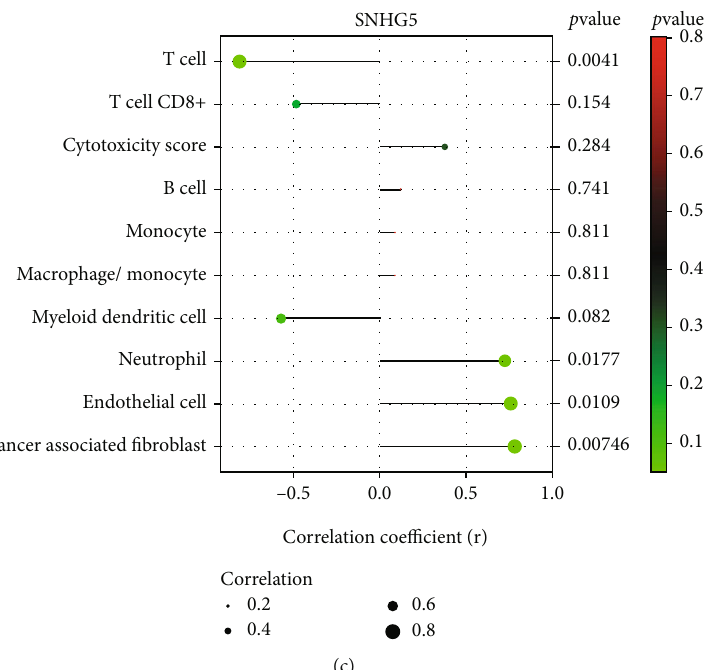
Figure 9: Correlation analysis results between genes and immune in fi ltrating cells. (a) Correlation analysis of immune in fi ltrating cells. (b) Correlation coe ffi cient plot of ATF2 and immune in fi ltrating cells. (c) Correlation coe ffi cient plot of SNHG5 and immune in fi ltrating